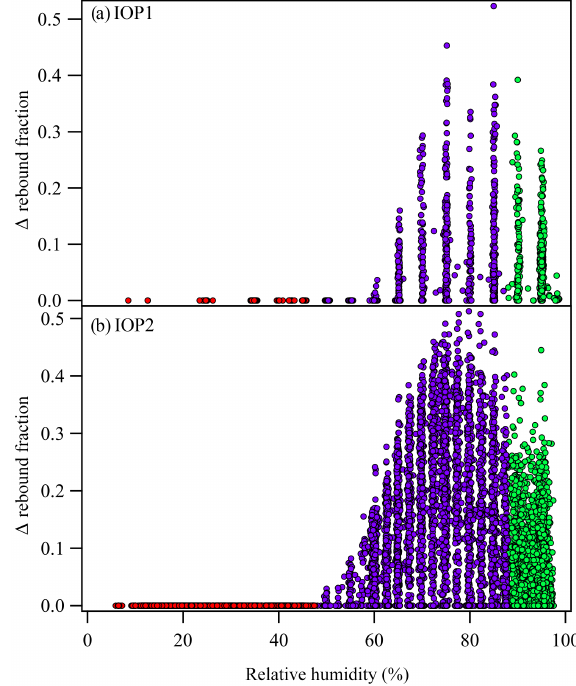
Figure 3. Deviation in rebound fraction relative to the average curve for background conditions during (a) IOP1 and (b) IOP2. Red, pur- ple, and green correspond to the RH regions of rebound, transition, and adhesion, respectively, for the background-average curve. Re- sults are shown for particles having a mobility diameter of